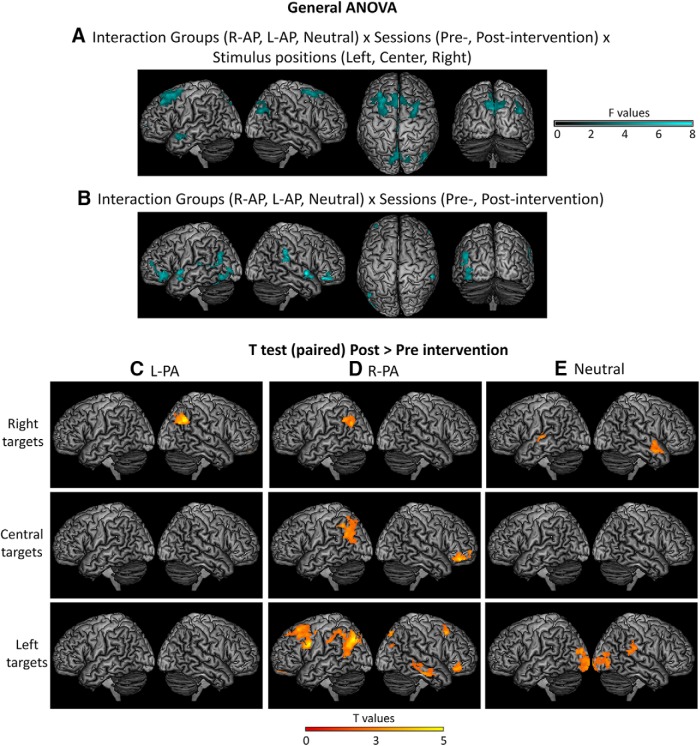
Surface renderings of the brain activation showing significant activation in the general mixed design ANOVA for the interaction between all three factors, group as the between-subjects factor and session and stimulus position as the within-subjects factors (A); and for the interaction between the factors group and session (B). C–E, Surface renderings of post hoc paired t tests (post > pre-intervention) for the L-PA (C), R-PA (D), and neutral groups (E) for each stimulus position separately. All maps are set at a threshold of p < 0.05 and k > 100 for the interactions and k > 150 for the t tests.